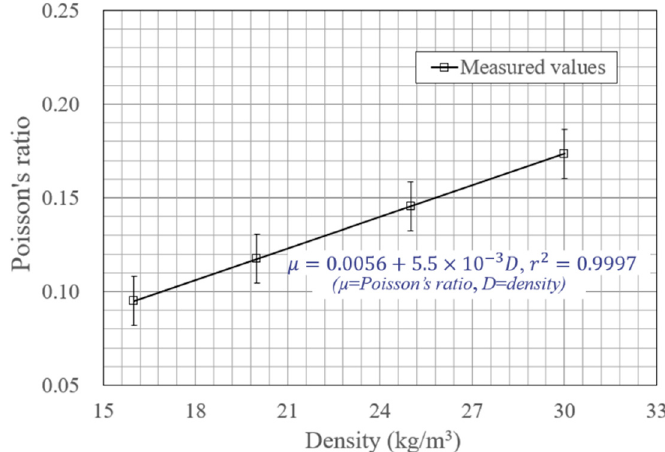
Figure 7. Poisson’s ratio, for different EPS densities.